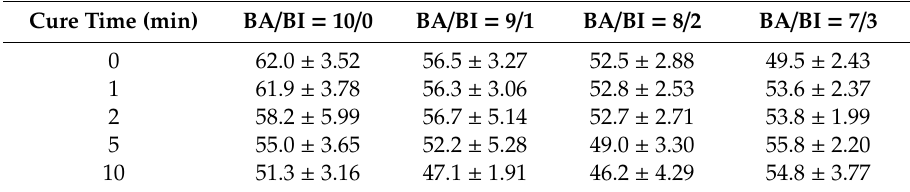
Figure 7. Shore D values at different UV curing times of the PBABI copolyesters. 0